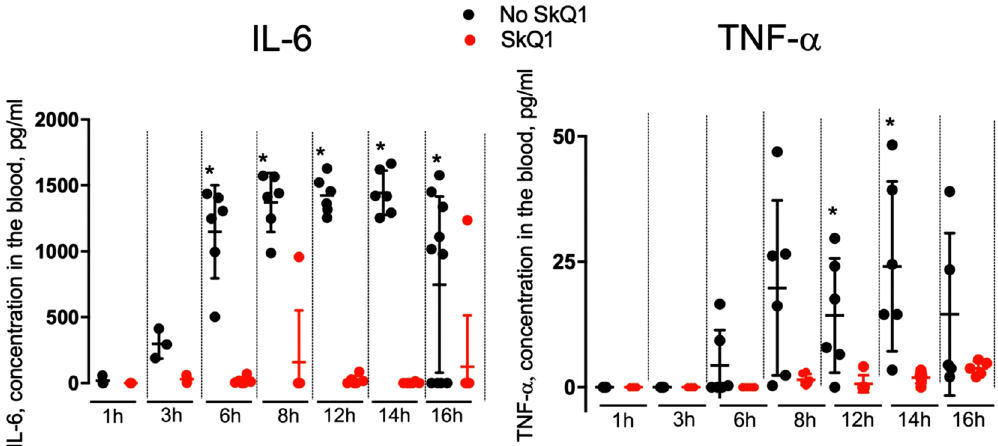
Figure 9. SkQ1 prevents increase in the level of proinflammatory cytokines IL-6 and TNF-α induced by cooling. Mice were placed at − 20 °C for 1 h and then returned to room temperature. SkQ1 (1.5 μmol/kg) was administered intraperitoneally for 5 days before cooling the animals. The group size was 40 mice. * p < 0.05.